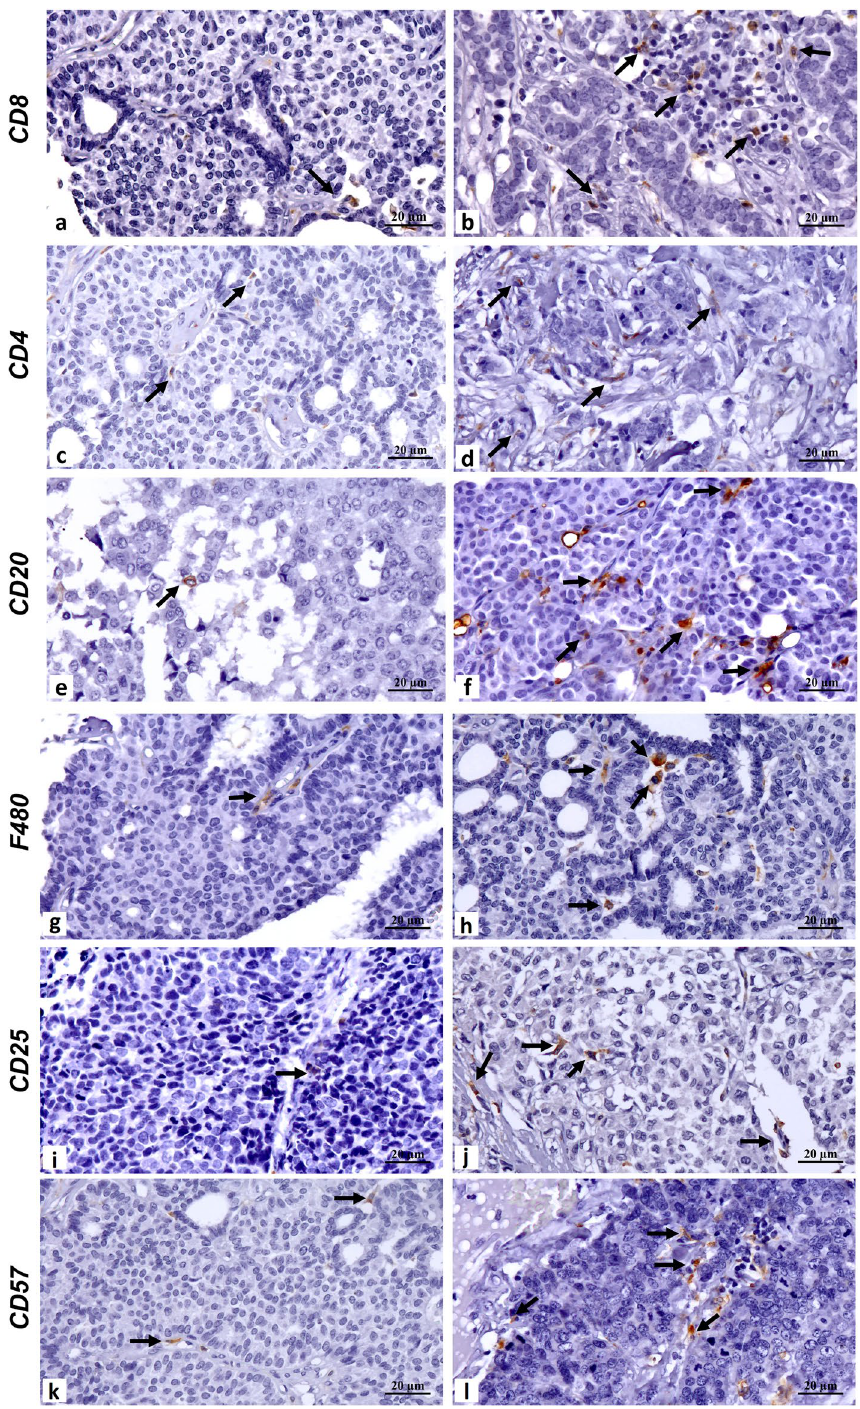
Figure 9. Immunohistochemical evaluation of CD8 + , CD4 + , CD20 + , F480 + , CD25 + and CD57 + immune cells. IHC analysis of tumors from Bortezomib-treated mice (Bor) or control-treated mice (PBS + DMSO). Tumor tissues from three mice in each group were analyzed and representative images were reported. ( a ) Image shows rare CD8 + lymphocytes (arrow) in a control-treated tumor. ( b ) Numerous intratumoral CD8 + lymphocytes (arrows) in a tumor treated with Bortezomib. ( c ) CD4 + immunohistochemical stain displays rare intratumoral lymphocytes (arrows) in a control-treated sample. ( d ) A Bortezomib- treated tumor sample characterized by several CD4 + lymphocytes (arrows). ( e ) A CD20 + intratumoral cell (arrow) in a control-treated tumor. ( f ) Moderate CD20 + inflammatory infiltrate (arrows) in a tumor treated with Bortezomib. ( g ) Image shows rare macrophages (arrow) in a control-treated tumor. ( h ) Numerous large macrophages (arrows) in a tumor treated with Bortezomib. ( i ) CD25 + immunohistochemical stain displays rare intratumoral lymphocytes (arrow) in a control-treated sample. ( j ) Moderate CD25 + immune infiltrate (arrows) in a tumor treated with Bortezomib. ( k ) A control-treated tumor characterized by rare CD57 + cells (arrows). ( l ) A Bortezomib-treated tumor sample characterized by several NK (CD57 + ) cells (arrows). Scale bars correspond to 20